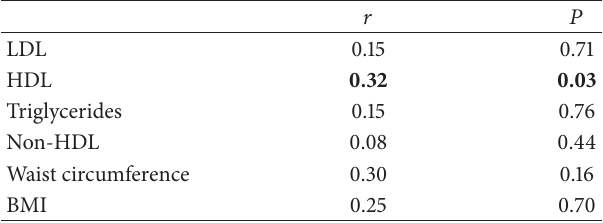
Table 2: Variables versus CIMT: multiple regression.